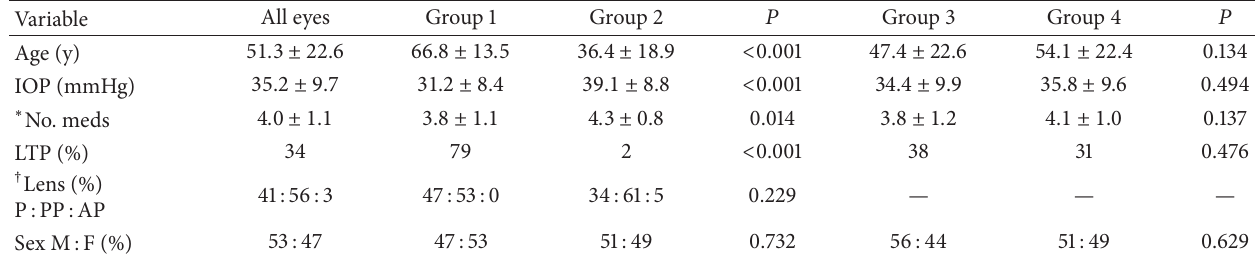
Table 1: Demographic data of study population and differences in demographic data between group 1 (primary open angle glaucoma and pseudoexfoliative glaucoma, 𝑛 = 38 ) and group 2 (uveitic glaucoma, 𝑛 = 41 ) and group 3 (no previous cataract surgery, 𝑛 = 45 ) and group 4 (previous cataract surgery, 𝑛 = 61 ).